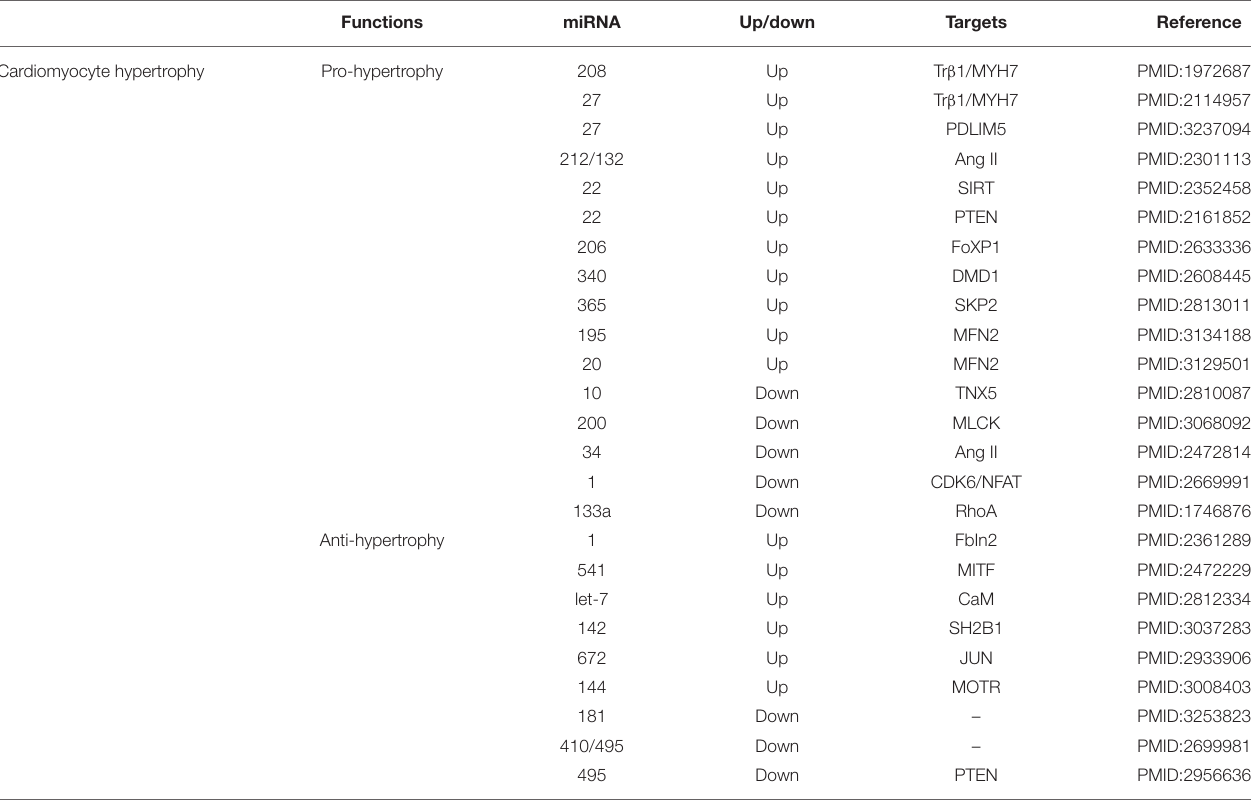
TABLE 3 | Micro RNAs targets and functions in cardiomyocyte